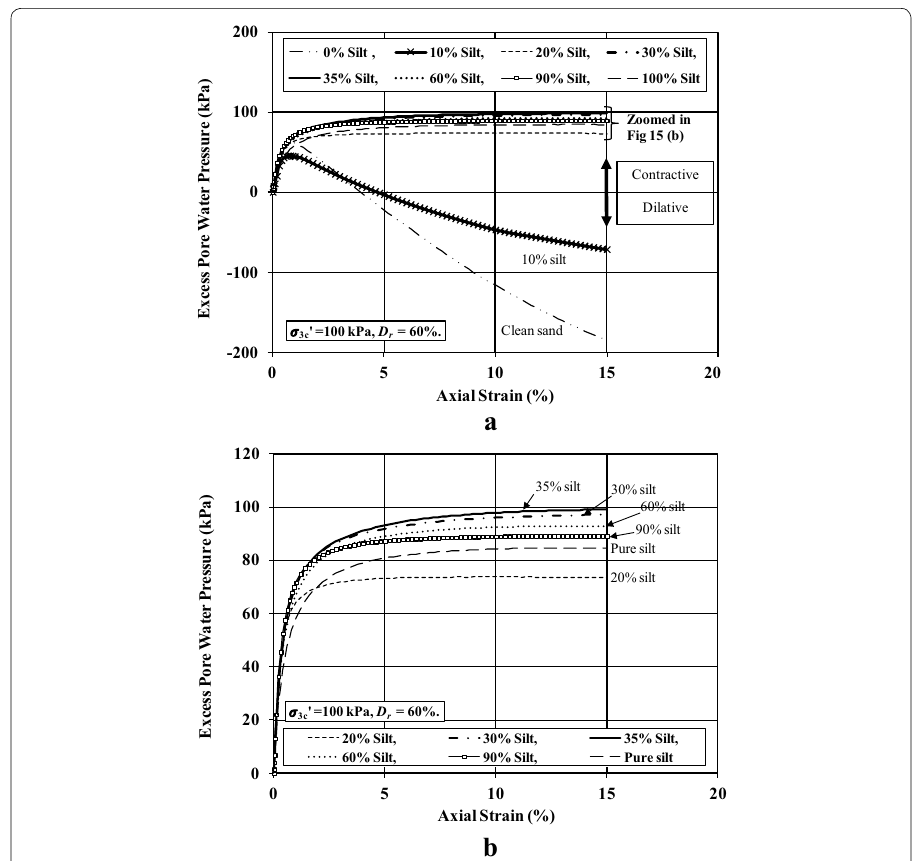
Fig. 15 Excess pore pressure versus strain curve at 60% initial relative density; a silt content 0–100% and b silt content 20–100%